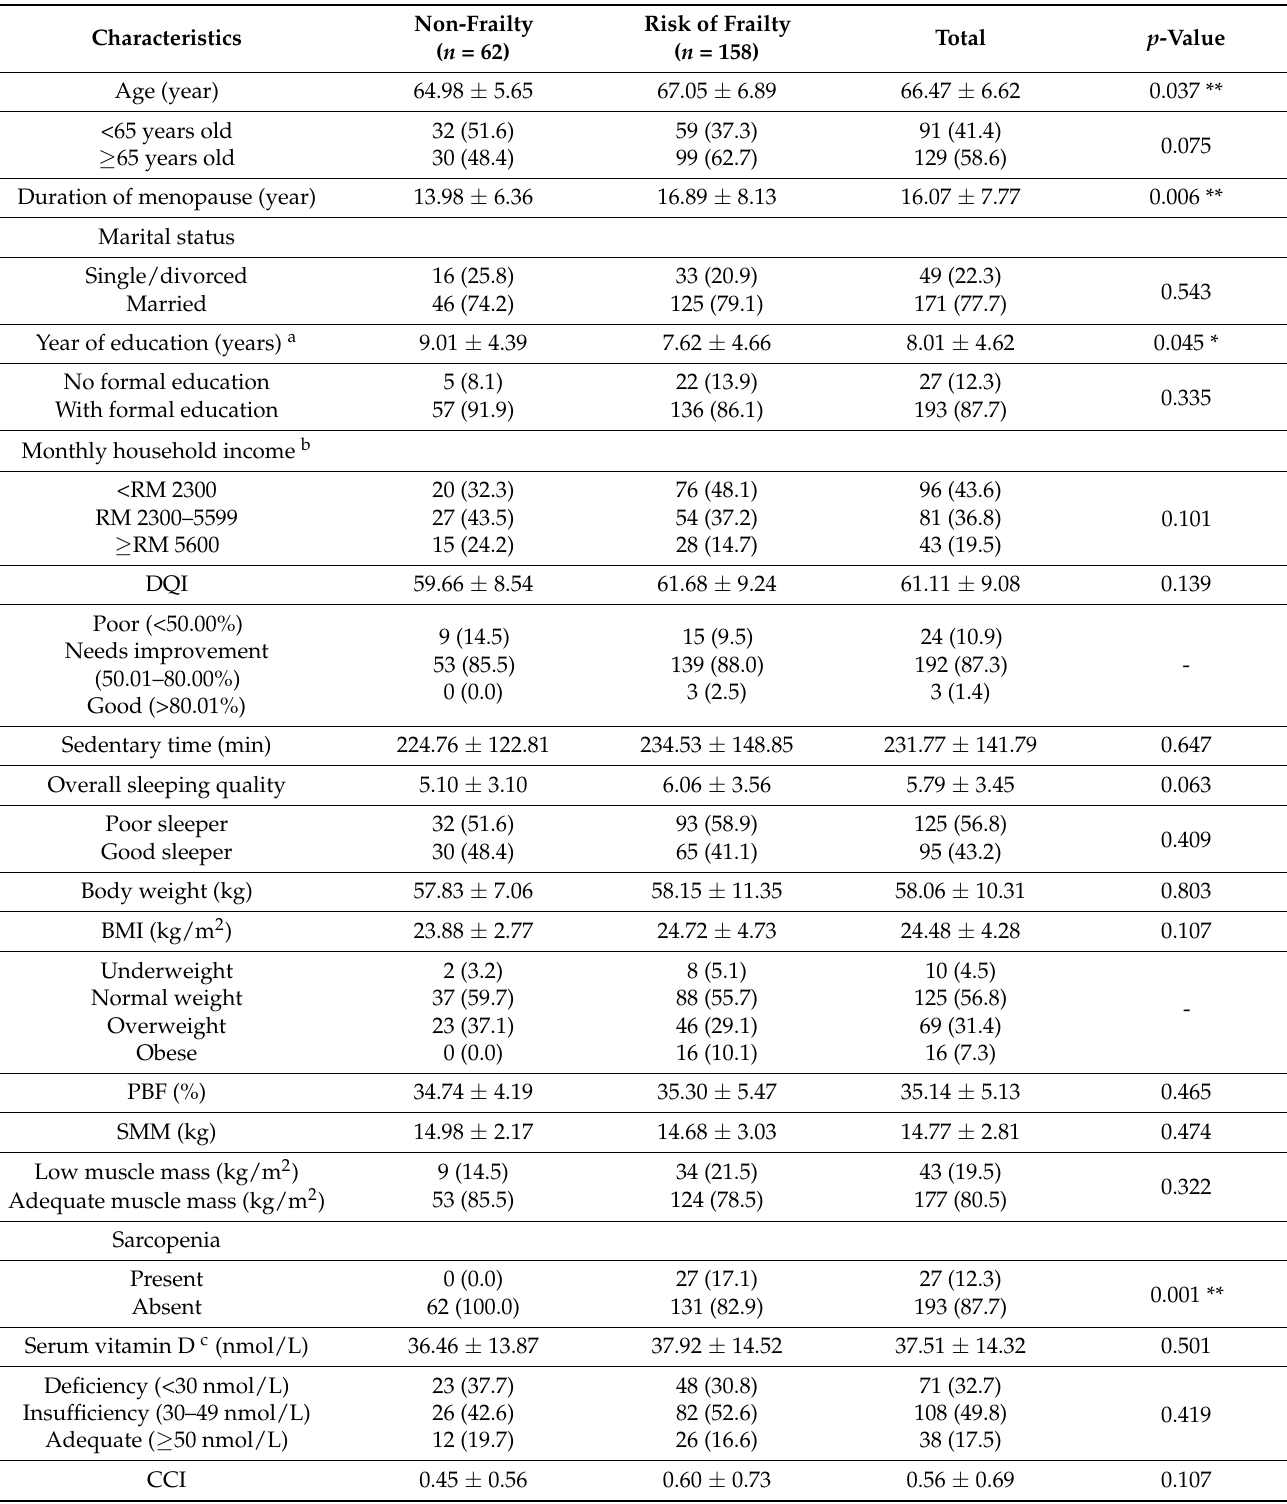
Table 2. Distribution of characteristics of respondents according to frailty status ( n =